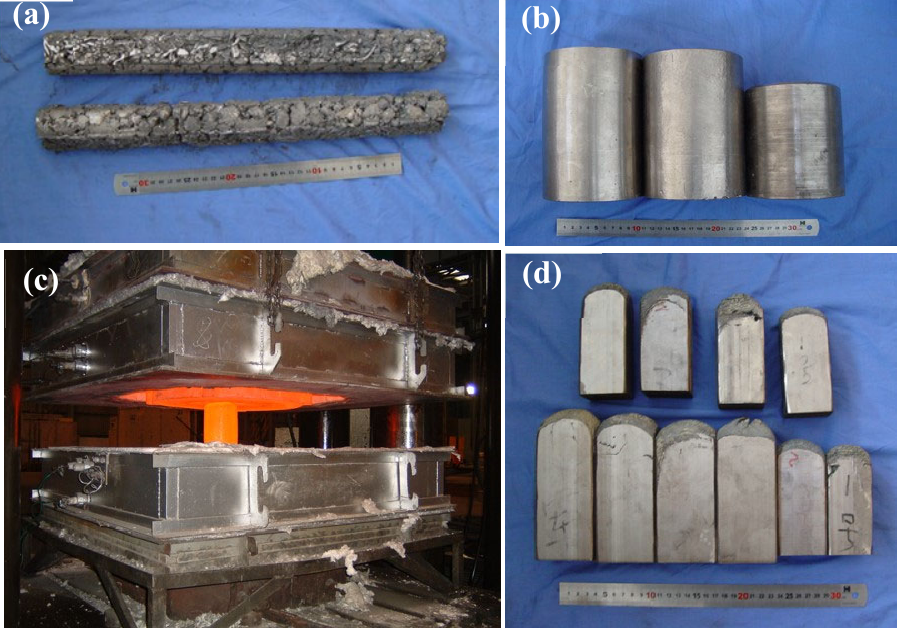
Figure 2. Photographs of the sample during the preparation of the composite. ( a ) Electrode made of the mixture of raw materials. ( b ) Ingots of the composite. ( c ) Thermal deformation of the composite. ( d ) The composite after thermal deformation.